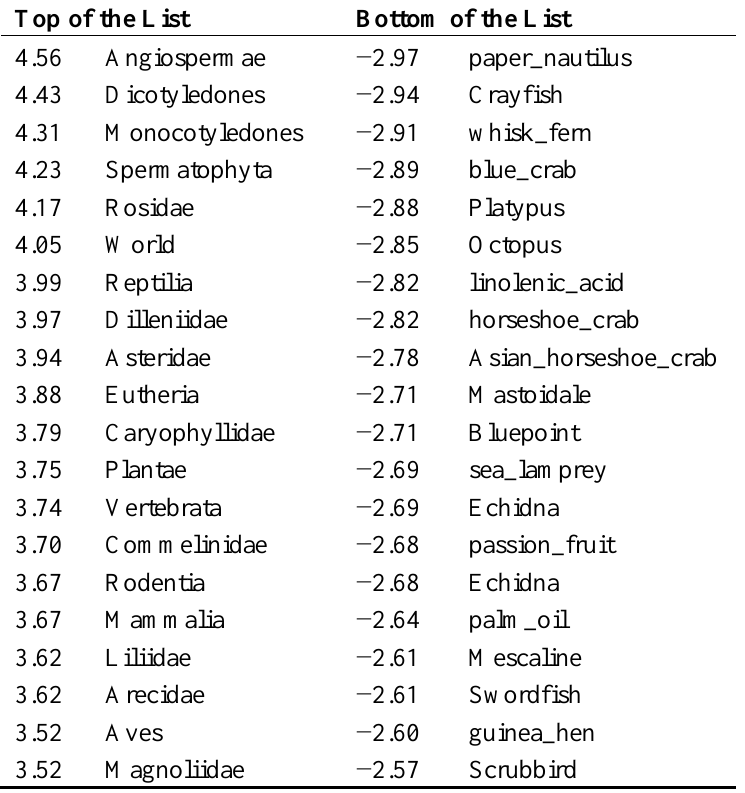
Table 3. Words sorted by completeness based on senses: two ends of the